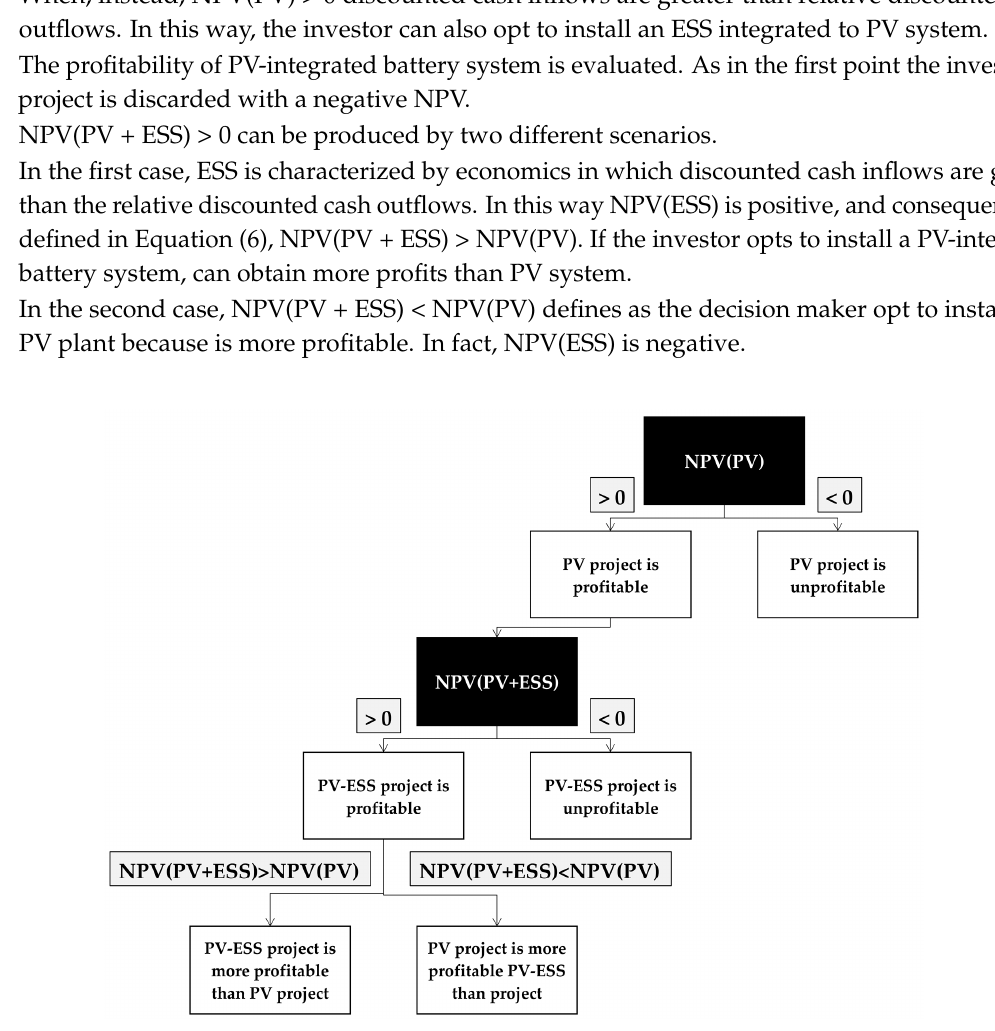
Figure 1. Decision-making process.